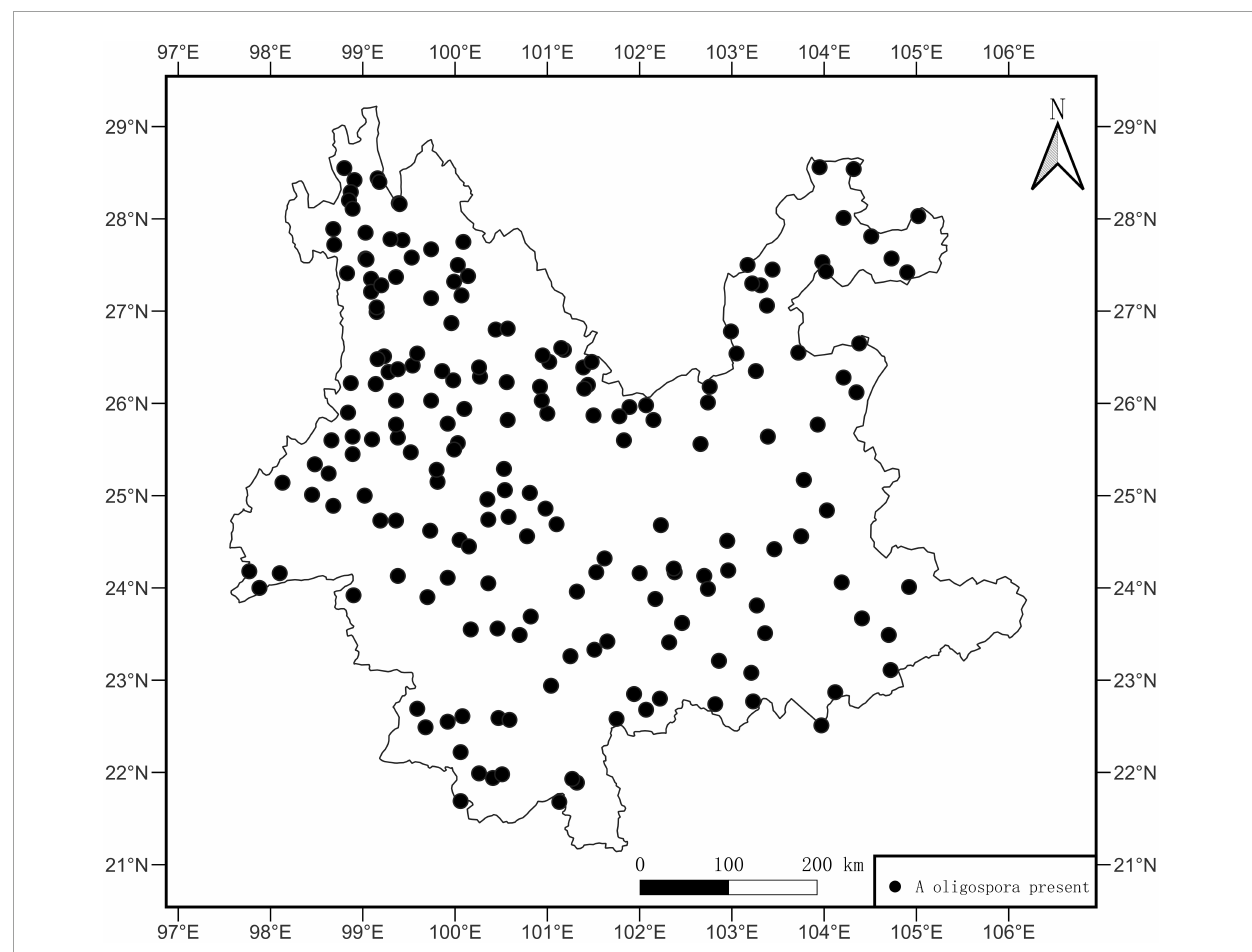
FIGURE2 Distribution map of A. oligospora . The black dots in the map represent sample sites where A. oligospora was detected.